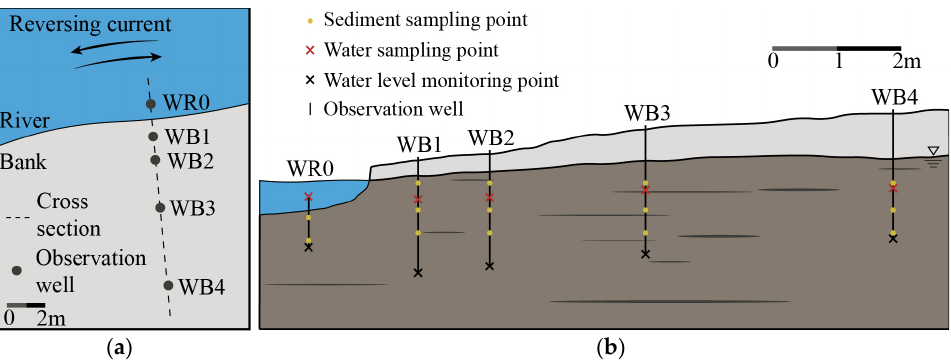
Figure 2. The transect for monitoring and sampling: ( a ) the top view; ( b ) the cross ‐ section. According to the preliminary work, the fluctuation range of the Jingzi River stage was mostly less than 0.5 m, and the change in groundwater table could not be observed as the river stage fluctuation was smaller than 10 cm (usually occurred during neap tides).